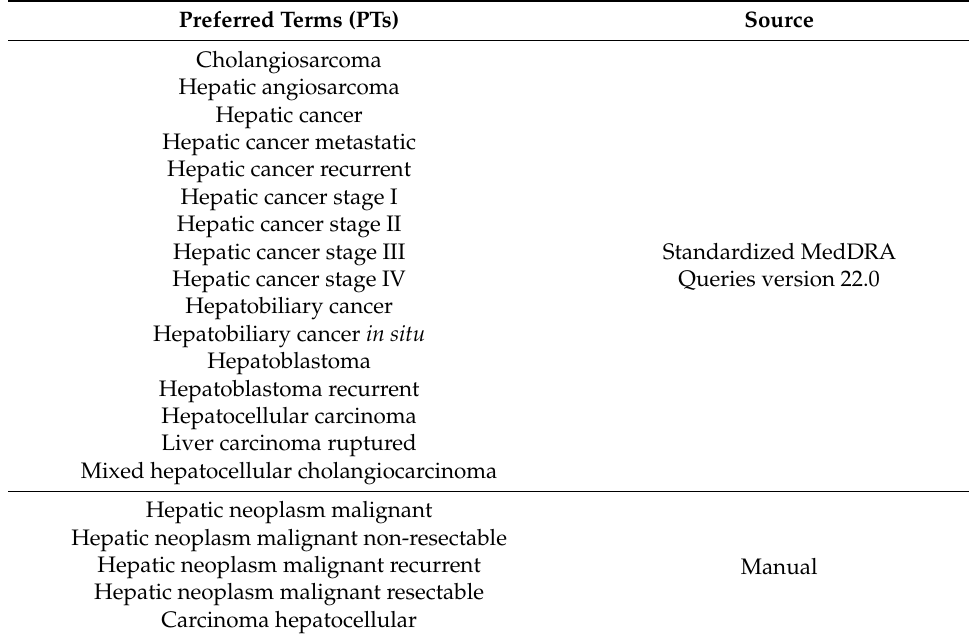
Table 1. Preferred terms for liver malignant